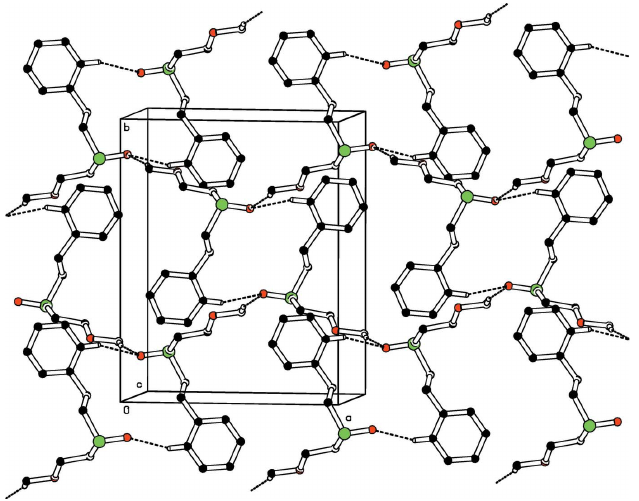
Figure 4 Part of the crystal structure of compound (II), showing the formation of an R 2 (14) ring. Dashed lines indicate hydrogen bonds. H atoms not 2 involved in the hydrogen bonding have been omitted for the sake of clarity.